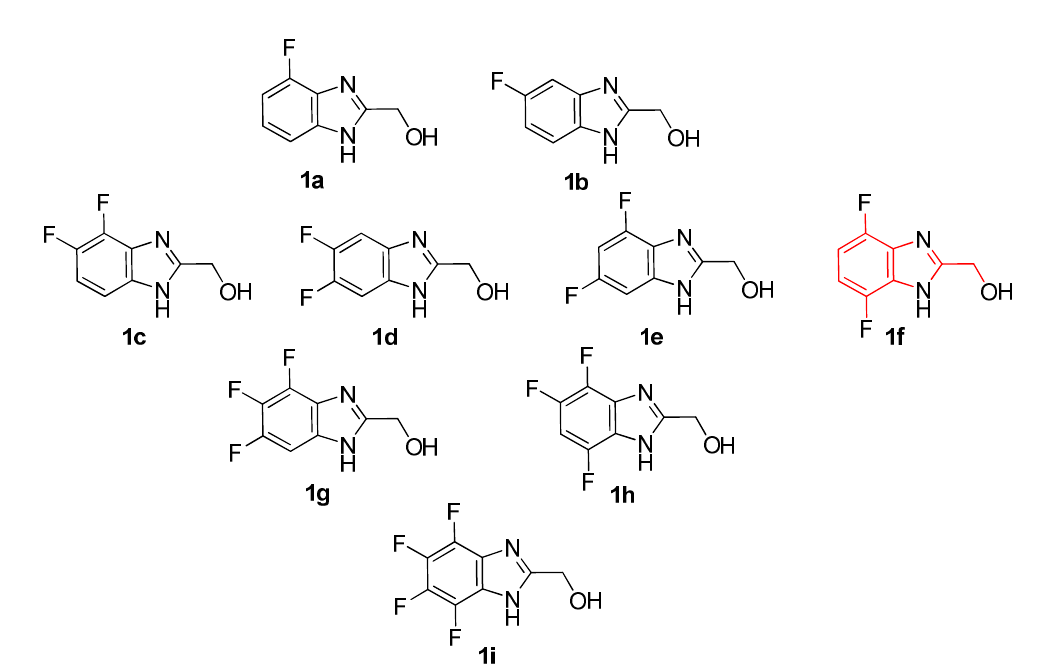
Figure 1. Synthesized in this work (black) and still challenging (red) (benzo[d]imidazol‐2‐yl)methanols fluorinated on the benzene ring, 1 a – i .